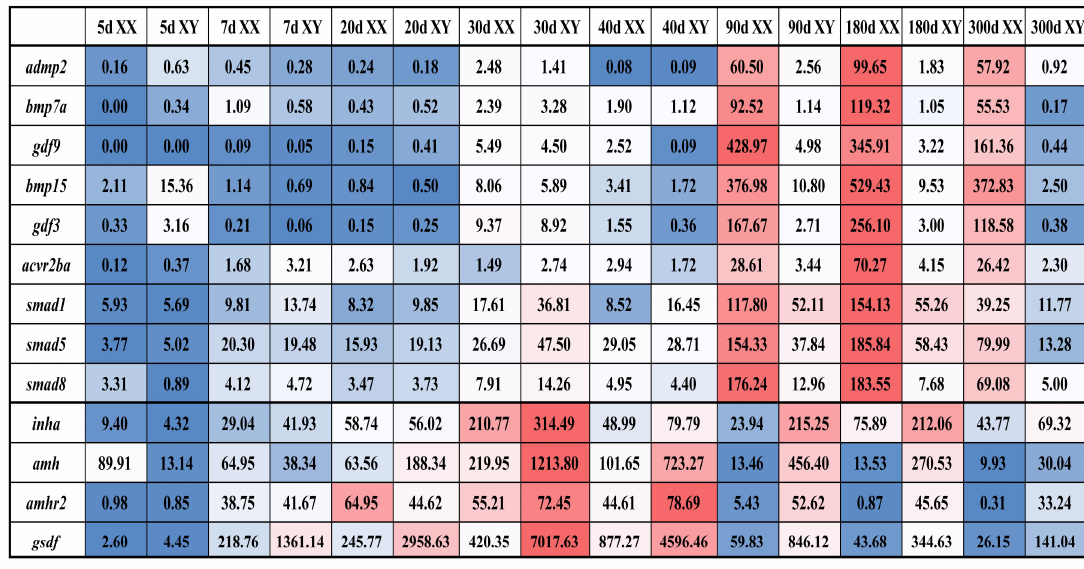
Figure 7. The expression profiles (FPKM) of TGF- β pathway members in the tilapia gonads. admp2 , bmp7a , gdf9 , bmp15 , gdf3 , acvr2ba , smad1 , smad5 and smad8 were ovary-enriched genes, while inha , gsdf , amh and amhr2 were testis-enriched genes. Red and blue indicate high and low expression, respectively.